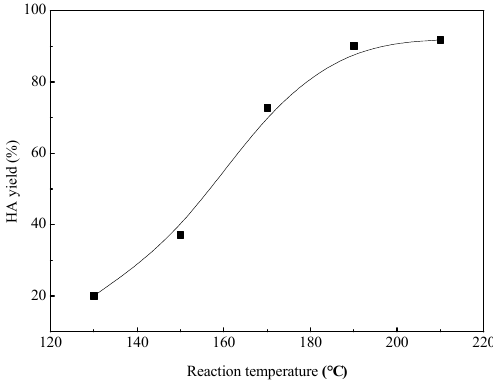
Figure 4. Effect of the reaction temperature on the HA yield.